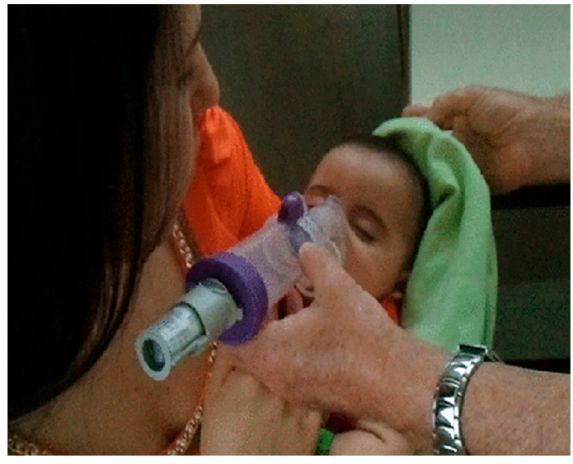
Figure 5. Photograph illustrating the method of aerosol administration to a sleeping infant showing the Respimat inhaler, InspiraChamber and SootherMask. (reproduced from [160] with permission from BMJ Publishing Group Ltd.).